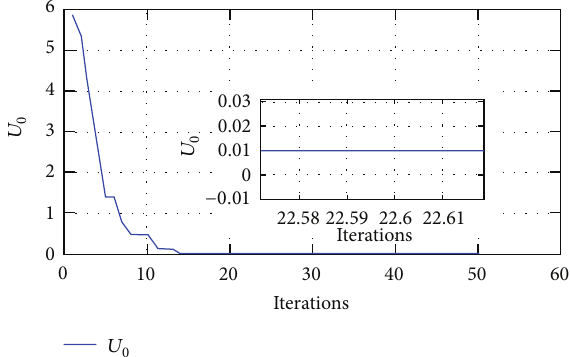
Figure 8: Conversion of 𝑈 0 during PSO solution